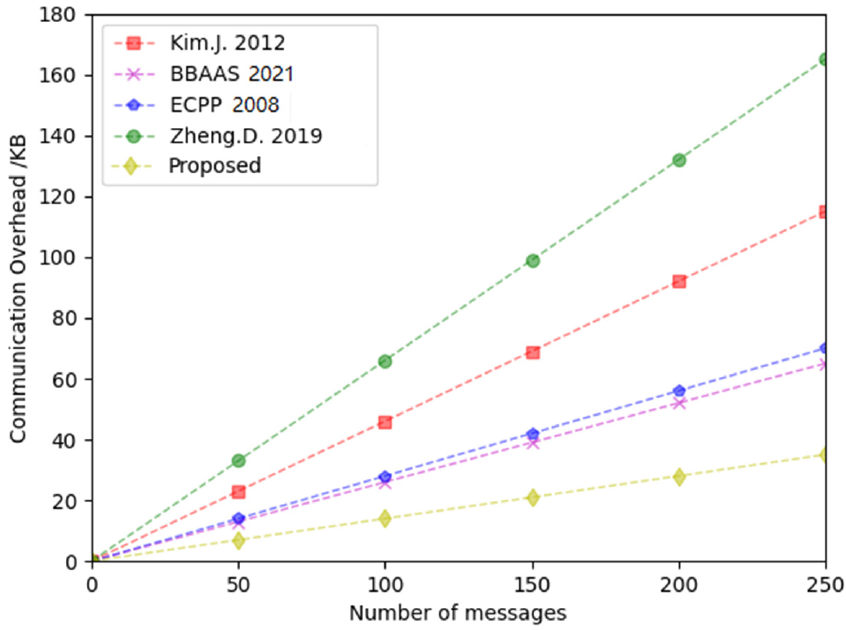
Figure 9. Comparison of communication overhead [15,21,23,24].